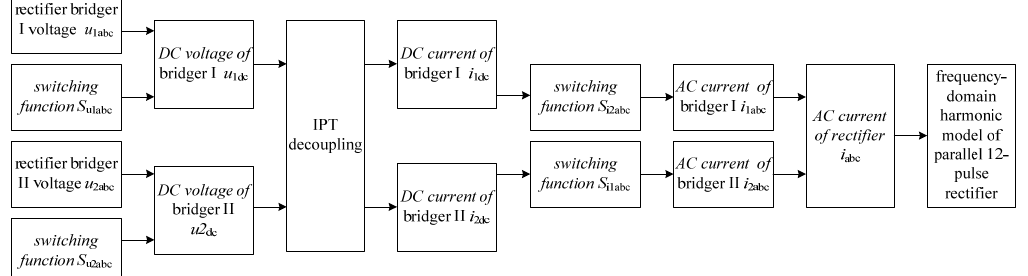
Figure 2. Harmonic analysis process of a parallel 12 ‐ pulse rectifier . The input voltages of bridges I and II are u 1abc and u 2abc , respectively. To analyze the harmonics of a parallel 12 ‐ pulse rectifier under unbalanced voltages, the voltage switch ‐ ing functions S u1abc and S u2abc and the current switching functions S i1abc and S i2abc are cor ‐ rected, which take the commutation overlap angle caused by the leakage inductance of the transformer and the firing angle offset caused by the unbalanced voltage into consid ‐ eration. Based on the input voltage and voltage modulation function of the parallel 12 ‐ pulse rectifier, the DC voltages u 1dc and u 2dc of bridges I and II are obtained: 1dc